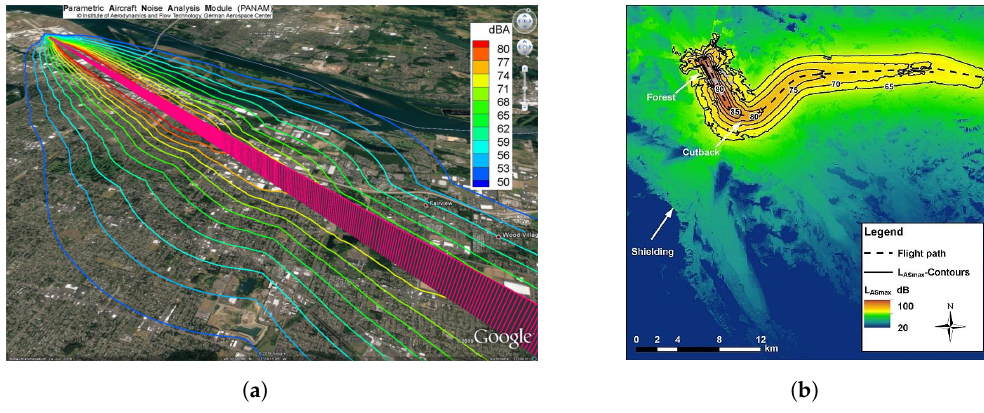
Figure 6. Examples of computation results of PANAM (single aircraft noise footprint) and sonAIR (multi-aircraft scenario noise exposures). ( a ) Noise exposure footprint of an approaching aircraft, computed using PANAM (Parametric Aircraft Noise Analysis Module). The isolines refer to the A-weighted ground noise level; ( b ) Acoustic footprint ( L A , S , max ) of an A330-300 take-off on runway 16 of Zurich airport. Specific source and propagation effects are labeled